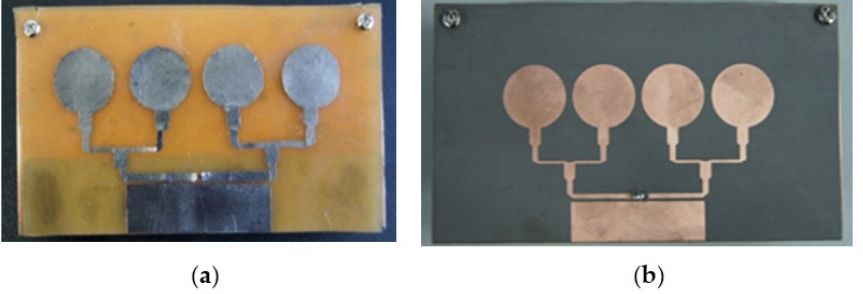
Figure 11. Comparison of fabricated antenna sensors ( a ) Magnetite PDMS Graphene Arraysensor and ( b ) Copper-Taconic sensor.